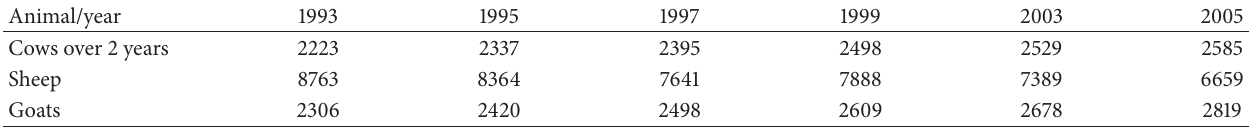
Table 3: Estimated historical data of livestock intended for breeding in Castelo de Vide.